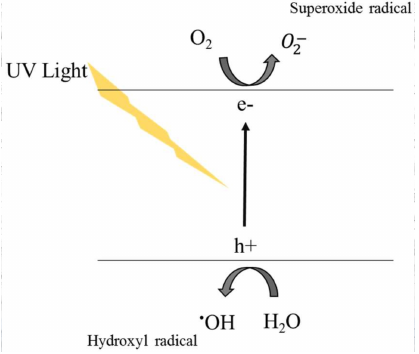
Figure 3. Photocatalytic mechanism of TiO 2 .